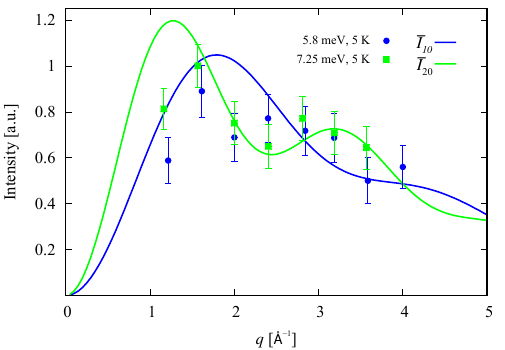
Figure 4. Normalized by γ n (cid:48) n INS intensities (solid lines) as a function of the magnitude of the scattering vector q along with the experimental data of Reference [9] for Na 9 [Er(W 5 O 18 ) 2 ]. Here, (cid:48) and n denote the final and initial energy levels of the transitions shown ¯ I = I n (cid:48) n n (cid:48) n / γ n (cid:48) n , where n in Figure 2a. The curves for ¯ I 10 and ¯ I 20 obtained with the aid of spin–sigma and Heisenberg Hamiltonians overlap.